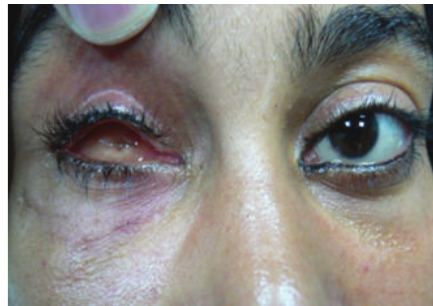
Figure 4: Intraoperatively fascia strip emerged through the periosteal tunnel in the medial skin wound and then it was tightened and tied around the periosteal bridge and secured with polyester 5/0 suture.